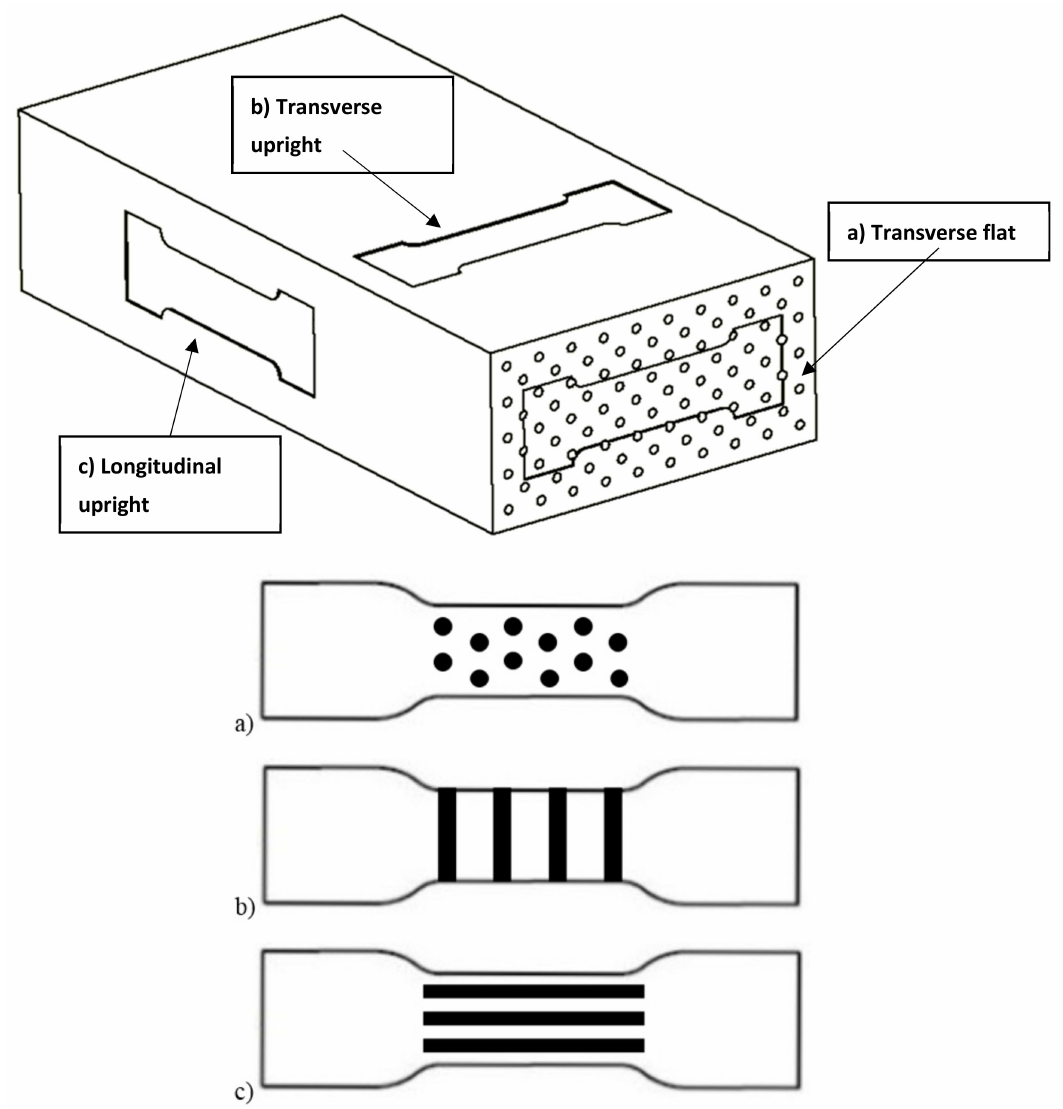
Figure 3. Orientation of the tensile specimens in layers (black represents Mn4Ni1.5CrMo); ( a ) transverse upright, ( b ) transverse flat, ( c ) longitudinal